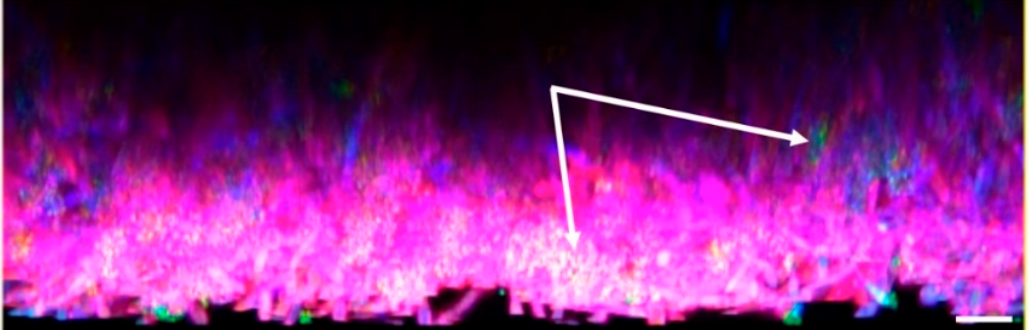
Figure 2. In vitro polymicrobial biofilm formation by C. albicans and S. aureus . The images demonstrates S. aureus (green / merged, white arrows) attached throughout the biofilm and along the hyphal filaments of C. albicans (blue). The extracellular matrix (red) largely encases a majority of the staphylococci. Methods: A polymicrobial biofilm was formed in vitro in RPMI-1640 medium with C. albicans (strain SC5314) and S. aureus (strain M2) using 1 × 10 6 CFU of each microbe to inoculate a Permanox chamber slide for 24 h at 37 ◦ C. Biofilms were washed with sterile saline to remove non-adherent cells, fixed in 4% formalin, and stained with a cocktail containing calcofluor white (50 µ g / mL), Concanavalin A-Texas Red (50 µ g / mL), and Syto9 (1.67 µ M). Images were captured using 405 nm, 488 nm, and 565 nm lasers and DAPI, FITC, and Texas Red filter sets with a Zeis 510 confocal scanning laser microscope. Corresponding Z-stacks were constructed using packaged Zeis software depicting a side view. Scale bar represents 20 µ